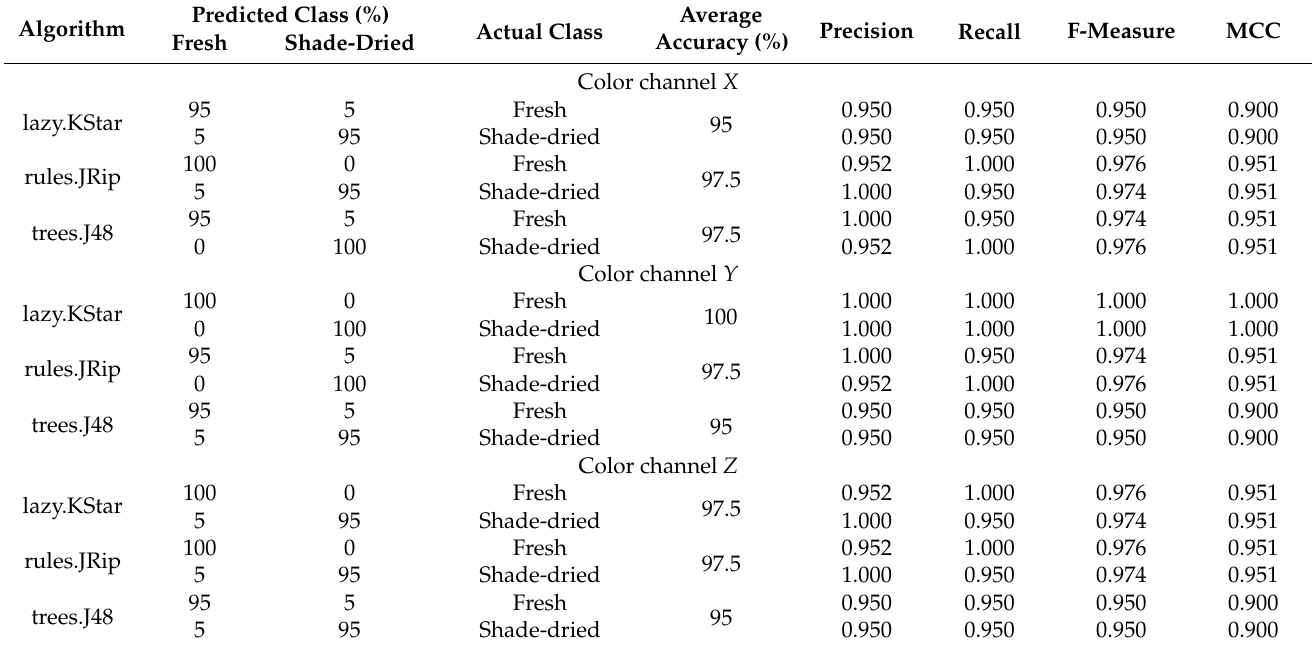
Table 3. The performance metrics of distinguishing images of the ventral side of fresh and shade-dried mint leaves using selected textures from color channels X , Y , and Z from color space